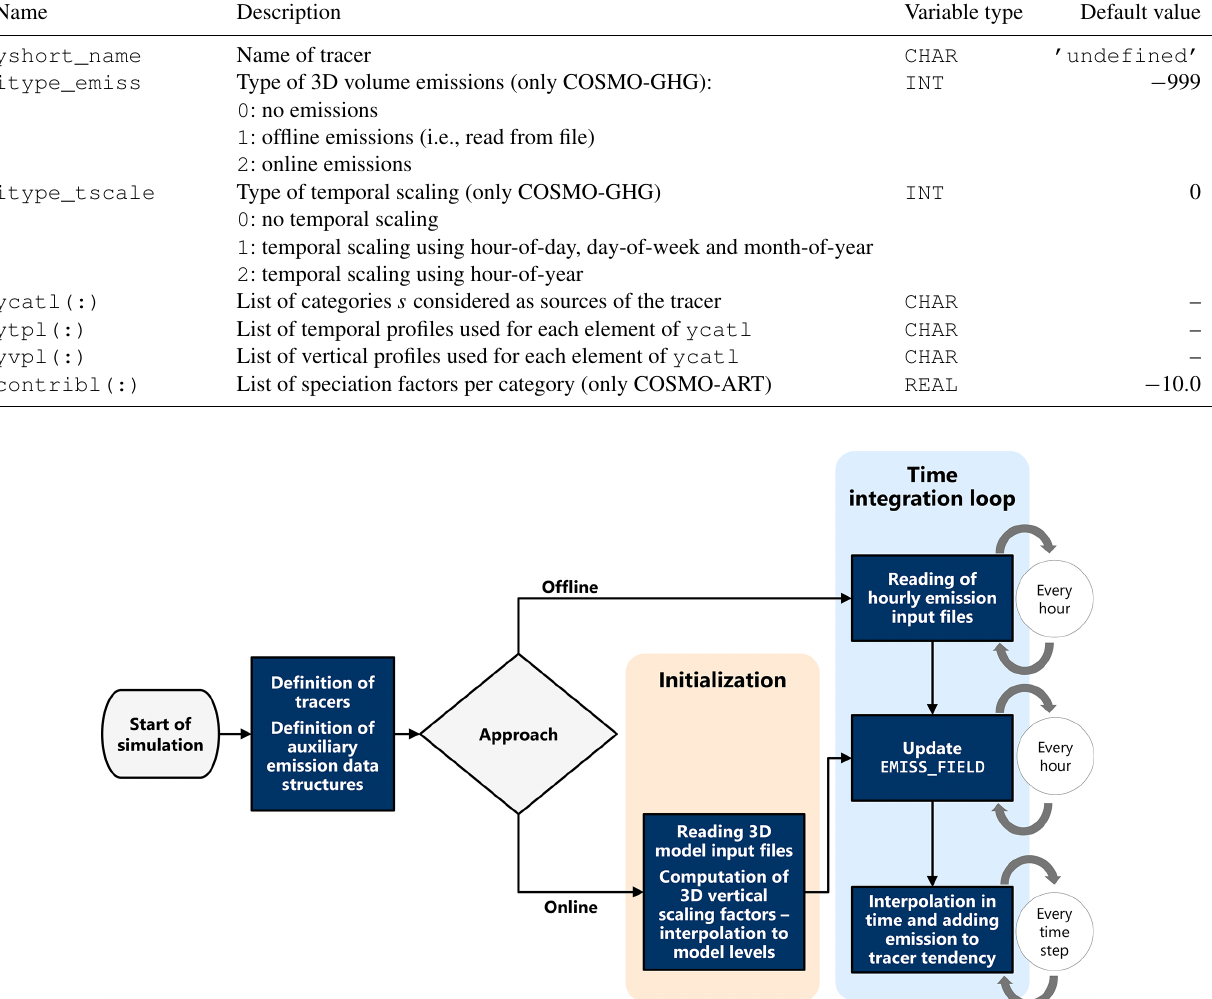
Table 3. Namelist members of the TRACER group in INPUT_GHG and INPUT_OAE . Some namelist members are only implemented in COSMO-GHG or COSMO-ART.